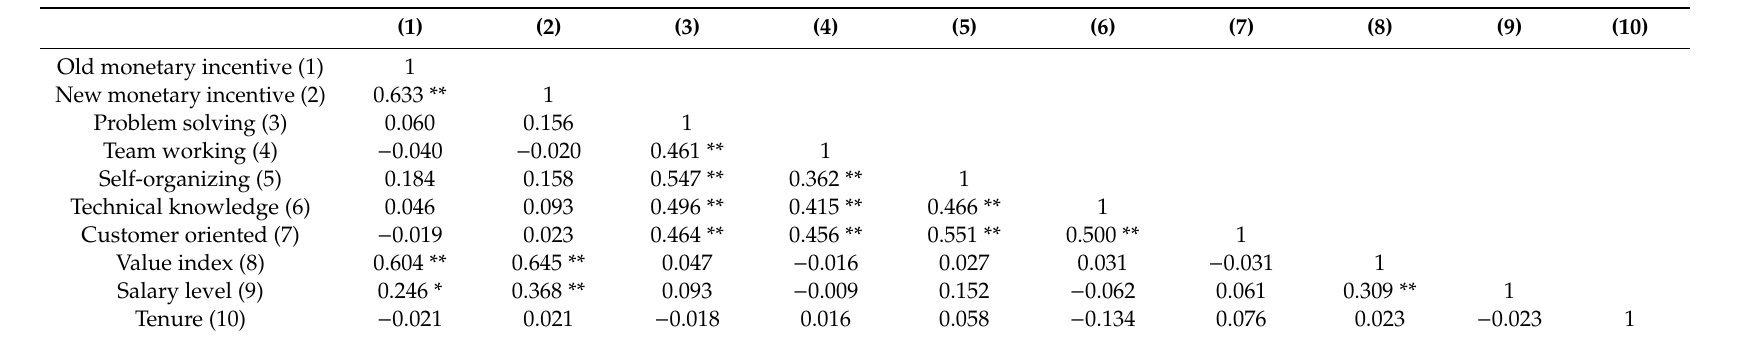
Table 5. Pearson correlations between predictors of the second